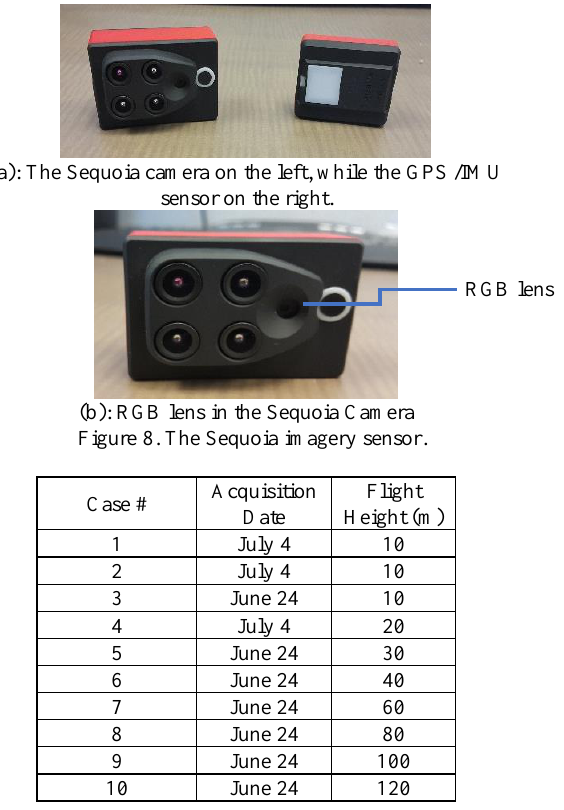
Table 1. List of the used images to evaluate the proposed